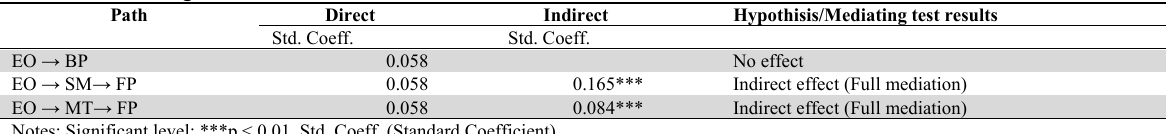
Results of mediating